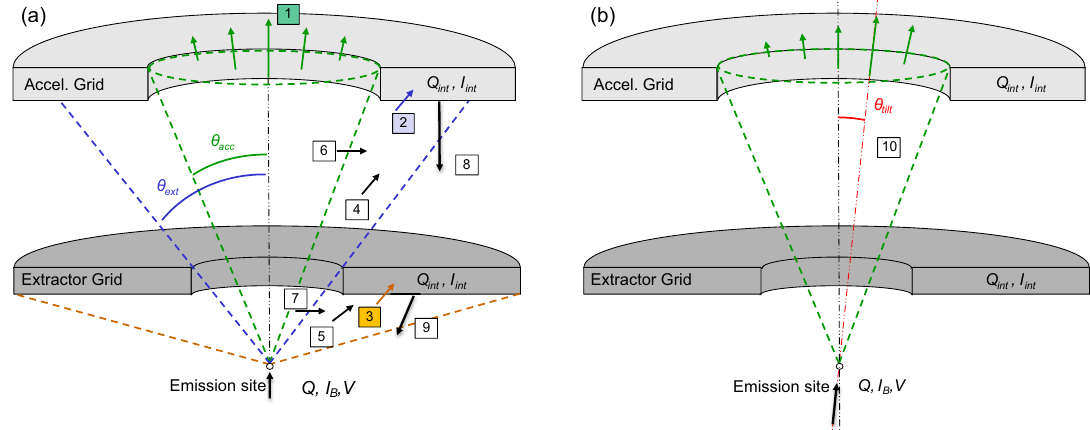
Figure 1. ( a ) Propellant flux contributors in an electrospray thruster, adapted from Ref. [9]. Most emitted propellant (i.e., over 90%) exits the device through the accelerator grid (1) [23–25]. Thruster lifetime is decreased by emitted propellant impinging on the accelerator grid (2) and extractor grid (3), which is caused by overspray (4 and 5) and plume expansion (6 and 7). ( b ) Illustration of the presented concept of “tilted emission,” which describes coaxial misalignment of the emission site and ideal thrust axis. The entire emission site is shown shifted by angle θ tilt . The ideal thrust axis is represented by the dashed black line in both images, which is the axis of alignment for the emitter, extractor, and